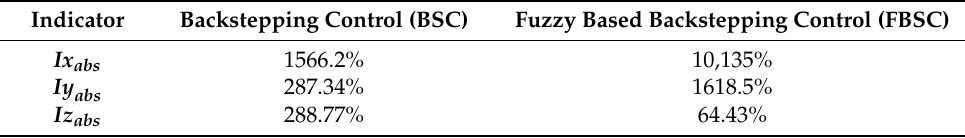
Figure 12. Roll, pitch and yaw responses using Fuzzy based Backstepping control under unmodelled dynamics and external disturbances. Table 4. Integral Absolute Error Values without Disturbances.